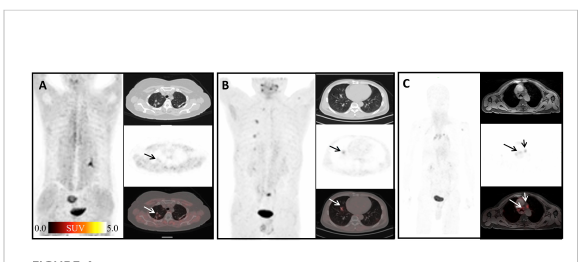
patient with gastric cancer 1 year after surgery; the arrows show organized pneumonia in the upper lobes of right lung with SUV max of 1.76. (B) A 60-year-old male patient after liver cancer surgery; the arrows indicate the in fl ammatory lesion in the middle lobe of the right lung with SUV max 3.24. (C) A 50-year- old male patient with weight loss of 10 kg in recent 6 months; arrows show mediastinal in fl ammatory lymph nodes with SUV max of 4.91.